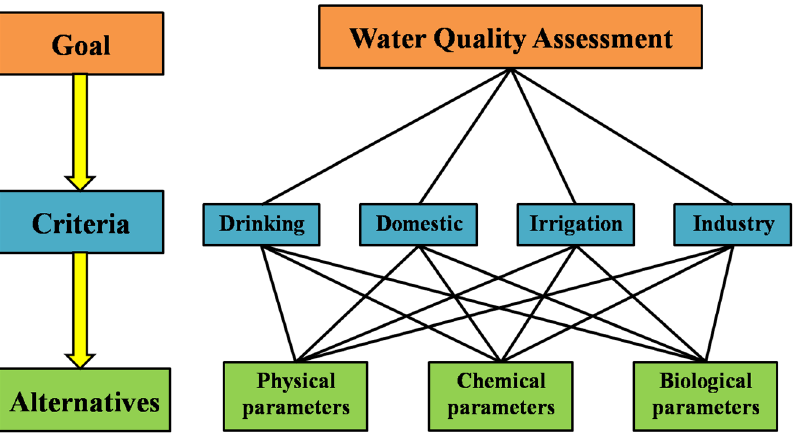
Figure 4. A common structure of the multi-criteria decision making (MCDM) method. When alternatives are selected, the total goal depends on the multiple criteria, where a goal is shown (water quality assessment) and criteria (drinking, irrigation, commercial, domestic) are indicated, as well as alternatives (physical, chemical and biological parameters).